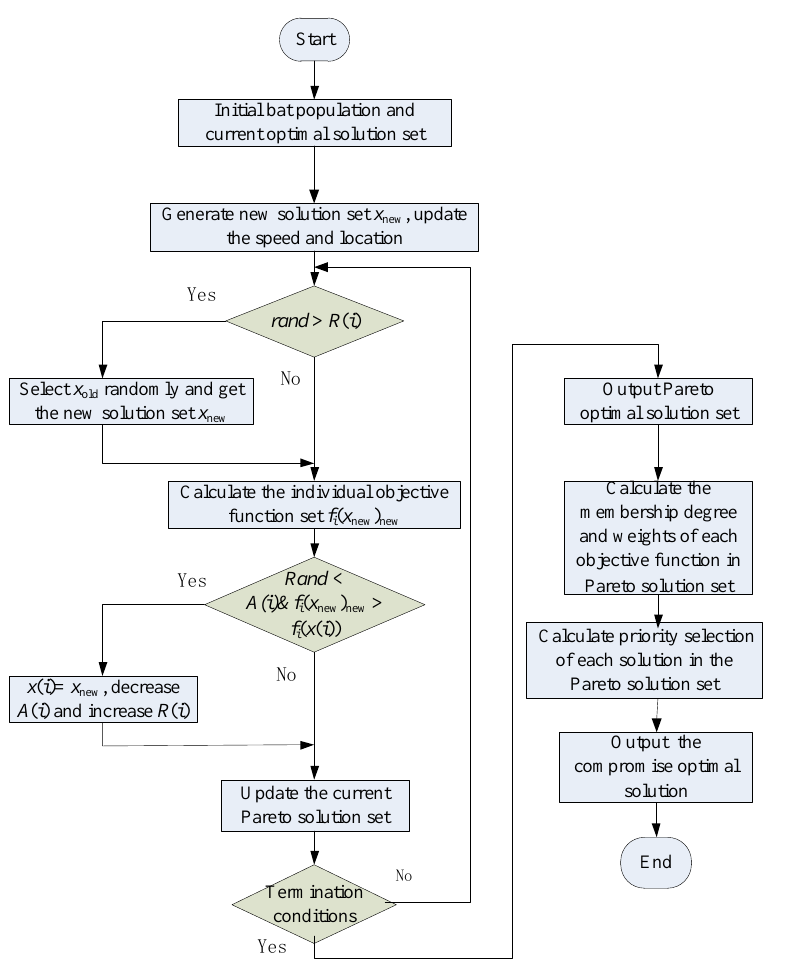
Figure 5. Flow chart of the improved bat algorithm based on priority selection.